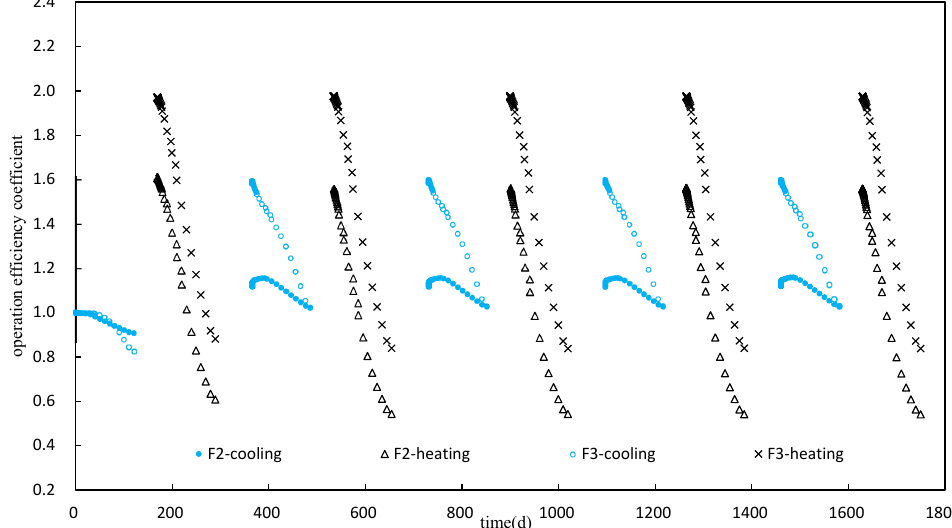
Figure 10. The relationship of operation efficiency coefficient vs. time for the present operation (F2 and F3).